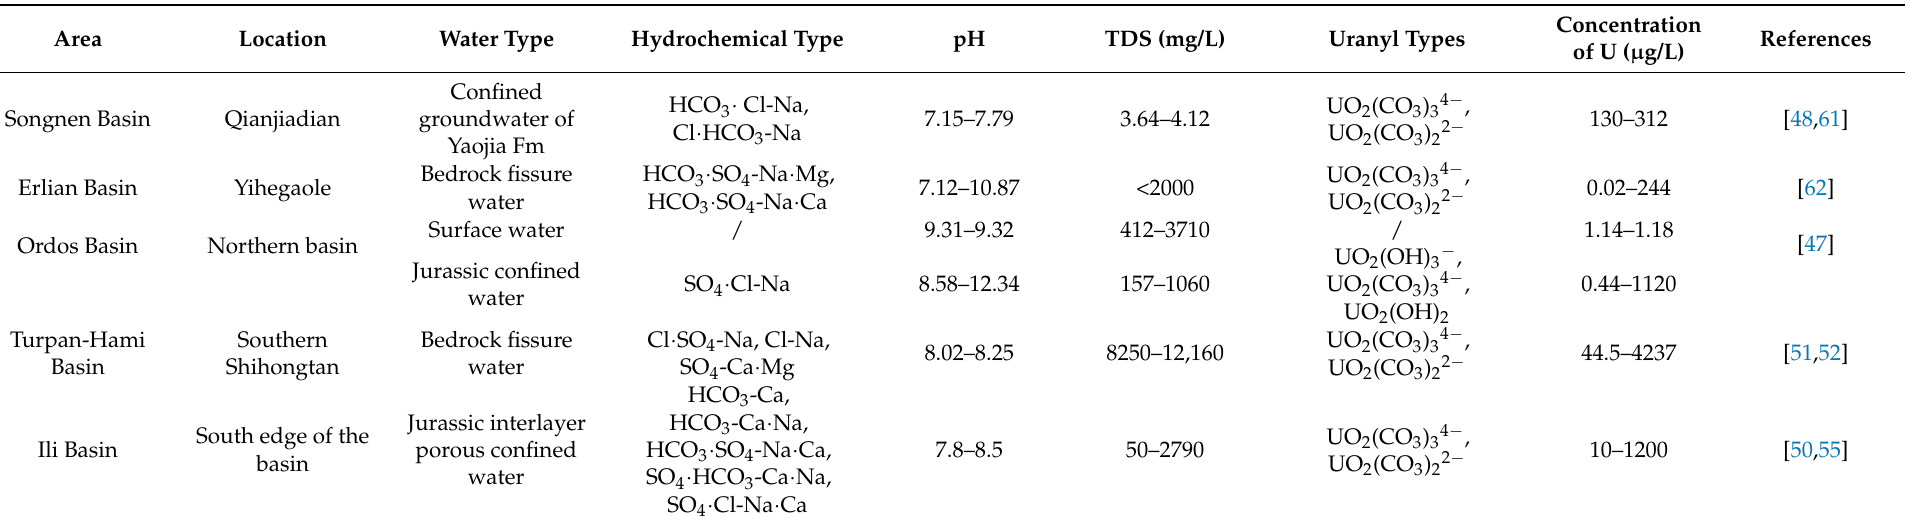
Table 1. Hydrochemical baseline of the representative ore belt in each